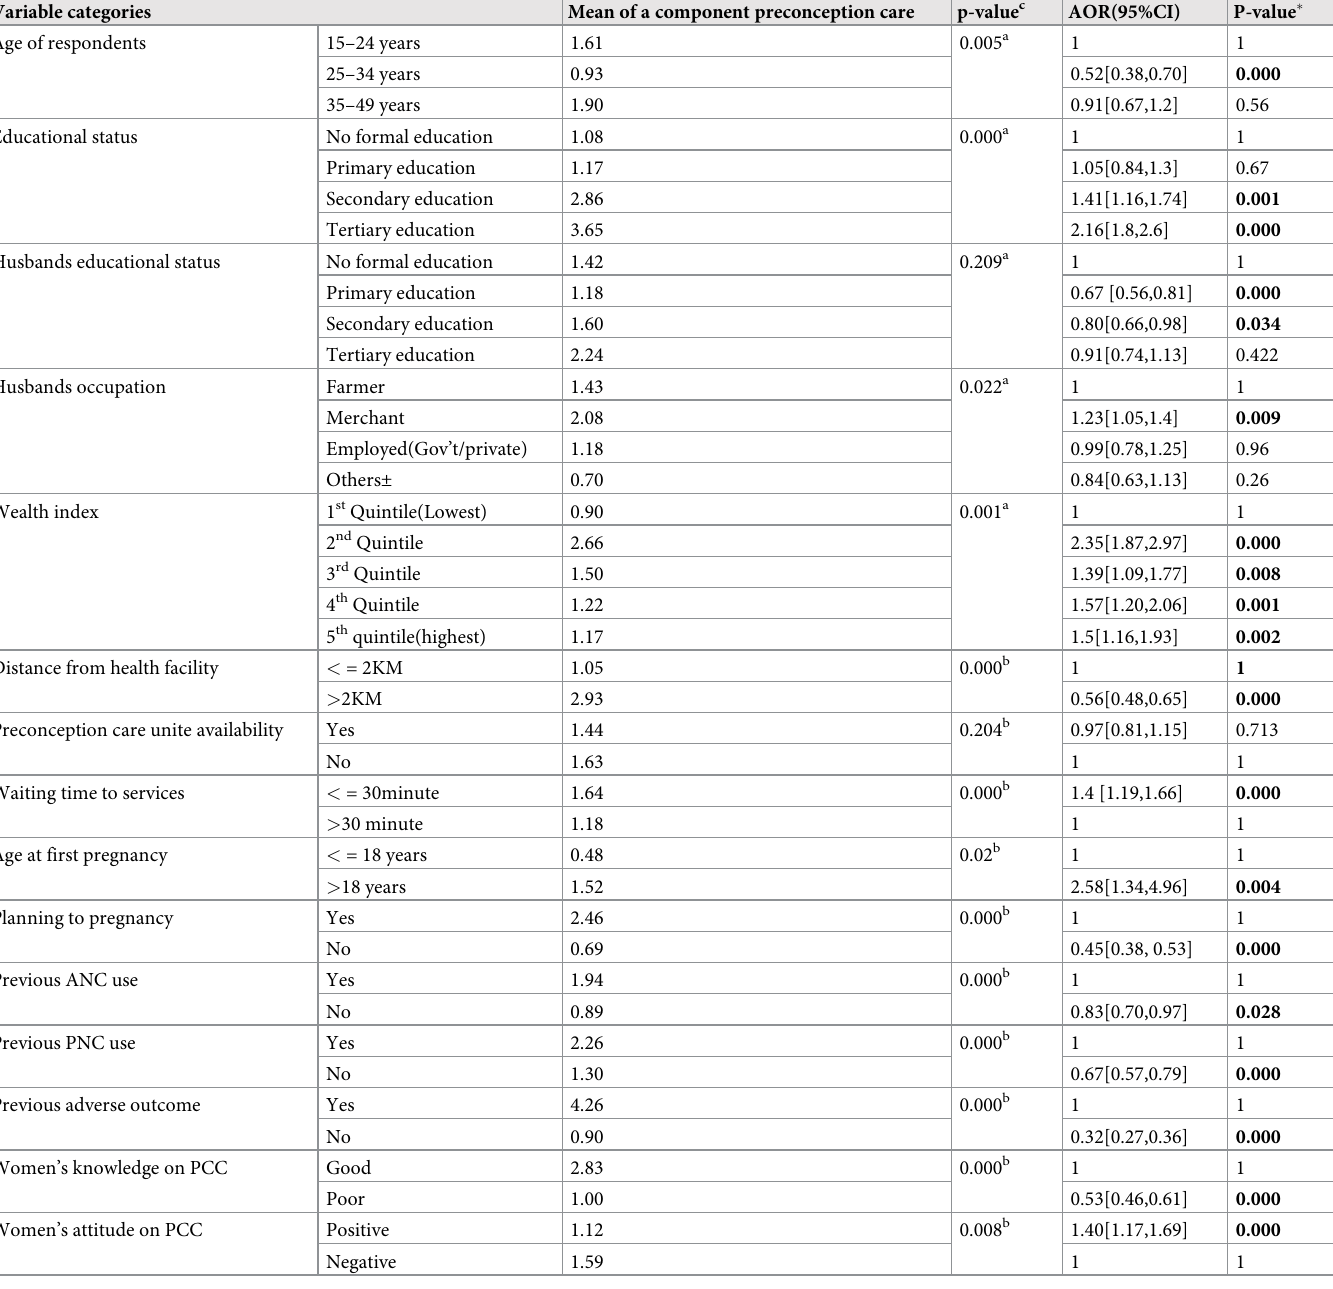
Table 5. Factors of preconception care utilization among reproductive age women using multivariable generalized linear regression model with Poisson link in Bench Sheko Zone, southwest Ethiopia, 2020. Variable categories